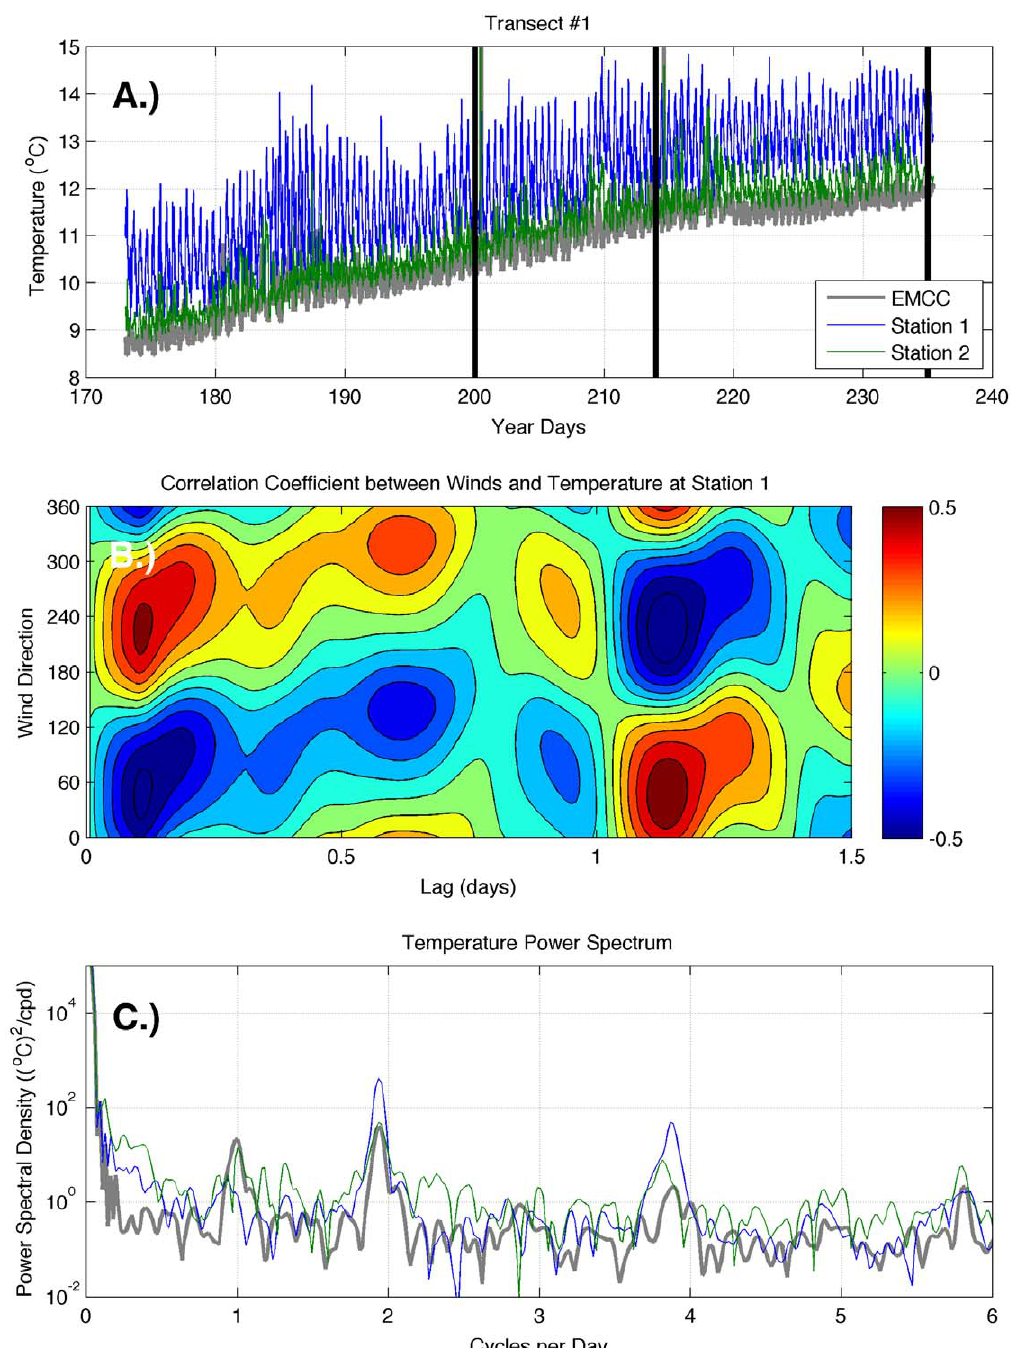
Figure 6. Temperature time series data (A) and analysis (B, C) for transect 1. The two analysis panels present wind-temperature correlations (B), and the power spectra of surface temperature (C). Station numbers begin near the coast and increase offshore. Vertical black lines indicate times of cruises. Note that wind direction refers to the direction that wind is blowing from . Due to its proximity to the mouth of the Bay of Fundy, transect 1 vertical stratification and weakest EKE (Figure 9d). Examination (Machias Bay) experiences greater tidal-induced vertical and of the tracks of drifters released during this study (Figure 10) horizontal exchange (Figure 9d). The greater mixing results in illustrates the strong geographic variation of EKE and its effect on alongshelf transport. Near the mouth of the Bay of Fundy, the flow less stratification in both the vertical and horizontal directions (top panels of Figures 2, 3, 4, 5) along transect 1. Transect 3 is restricted by the Maine coastline and Grand Manan Island (Frenchman Bay) exhibits the greatest horizontal gradients and within the Grand Manan Channel. Here, the drifters tend to move